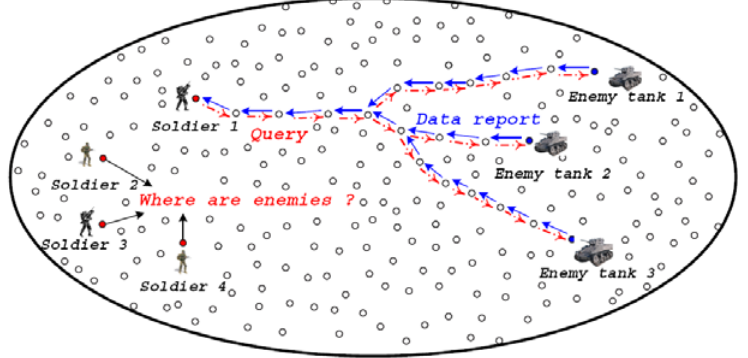
Figure 1. A sensor network example. Soldiers use the sensor network to detect tank